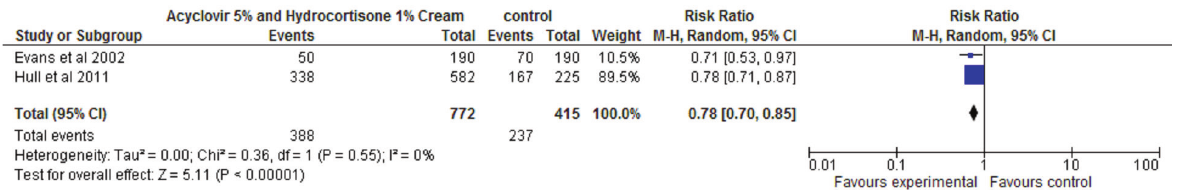
Figure 3 - Assessment of study